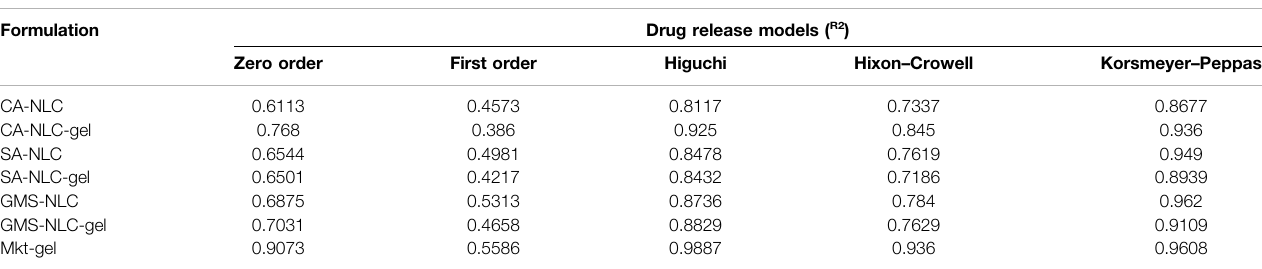
TABLE 2 | Drug release models for the in vitro release